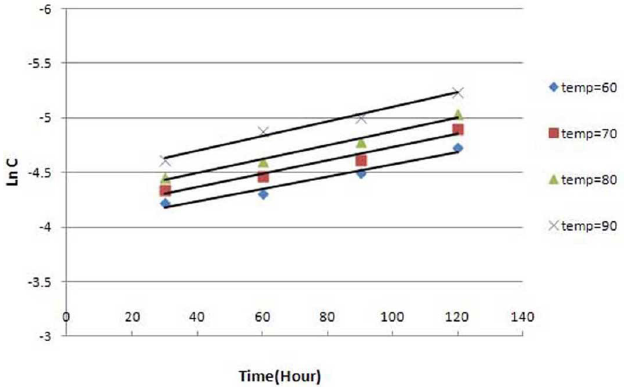
FIGURE 2 - The first order reaction plot of HCTZ-lactose liquid mixture at pH=13.1 after 30, 60, 90 and 120 minutes incubation at 60, 70, 80 and 90 °C.